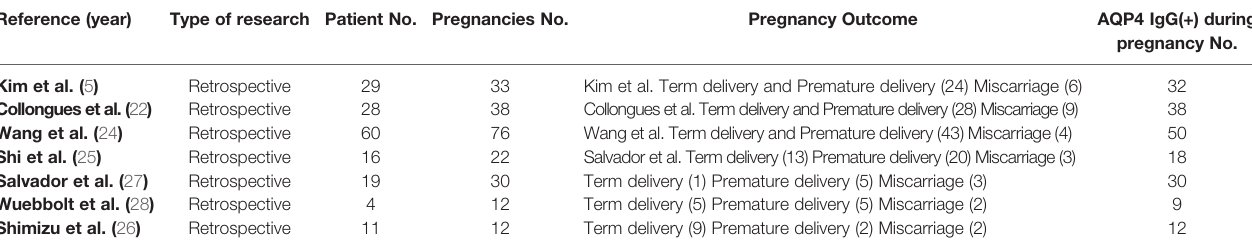
TABLE 3 | Clinical characteristics of 167 patients with 223 pregnancy-related neuromyelitis optica spectrum disorder attacks from 7 studies included in the meta- analysis. Reference (year) Type of research Patient No. Pregnancies